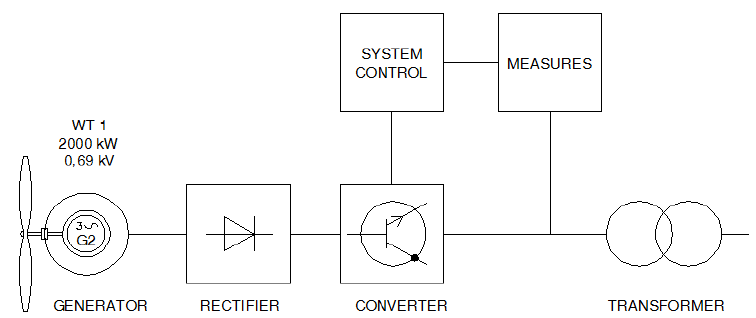
Figure 2. Grid connection monitoring on the wind turbine [7].